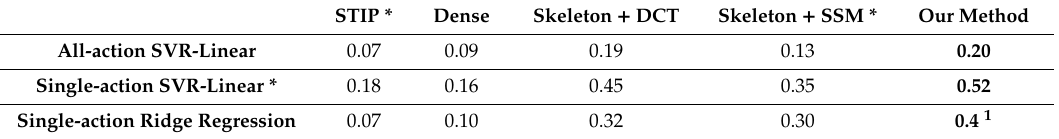
Table 1. Quality assessment results on the Massachusetts Institute of Technology (MIT) diving dataset. The average rank correlation coe ffi cients between the predicted results and the ground truth of di ff erent feature representation and evaluation methods are presented (The higher the value, the better the